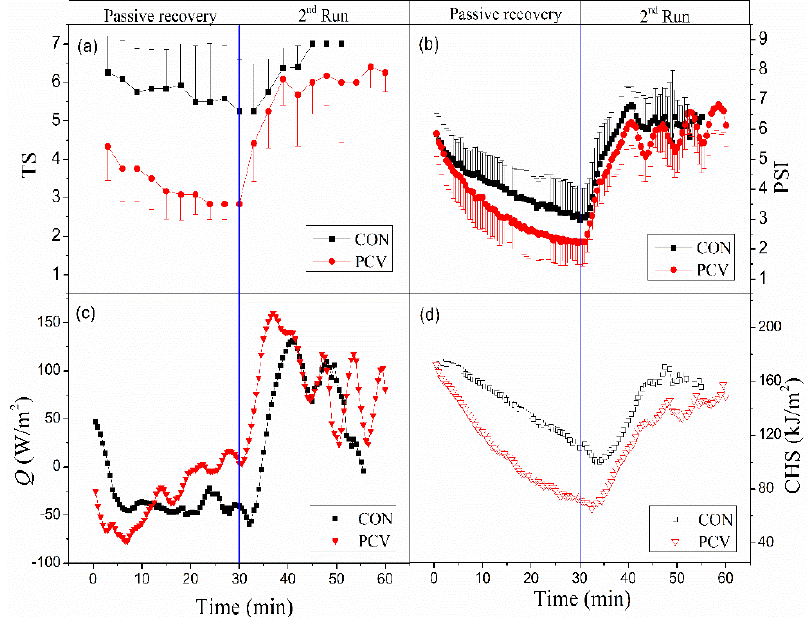
Figure 4. Comparisons of ( a ) thermal sensation (TS), ( b ) physiological strain index (PSI), ( c ) thermal load ( Q ), and ( d ) cumulative heat storage (CHS) in CON with those in PCV.